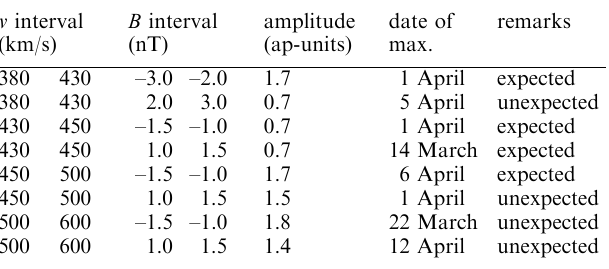
Table 1. Examples of amplitudes and phases of the semiannual wave of ap for di(cid:128)erent solar wind speed v and IMF B z intervals v interval B